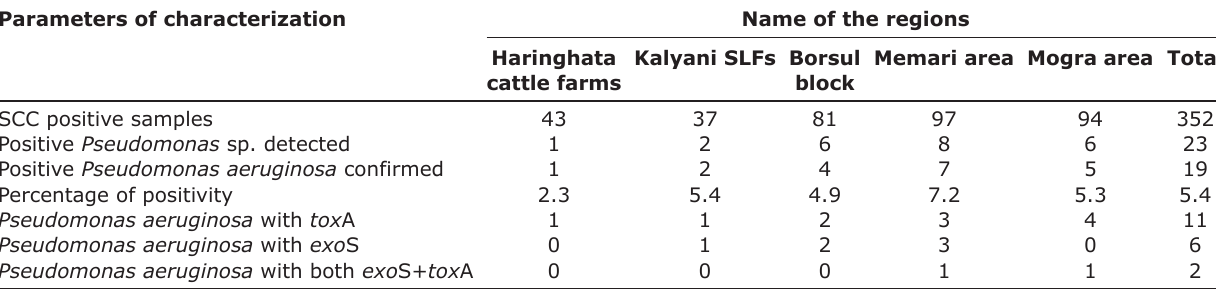
Table-2: Distribution pattern of Pseudomonas aeruginosa isolates in different regions with genetic characterization. Parameters of